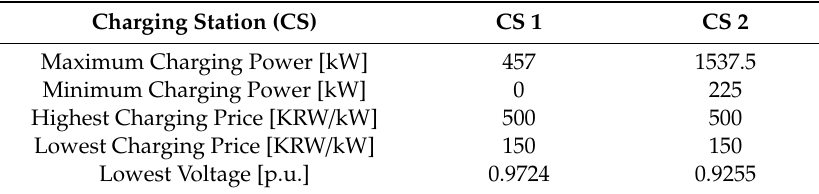
Table 2. Summary of simulation results in Case 1.